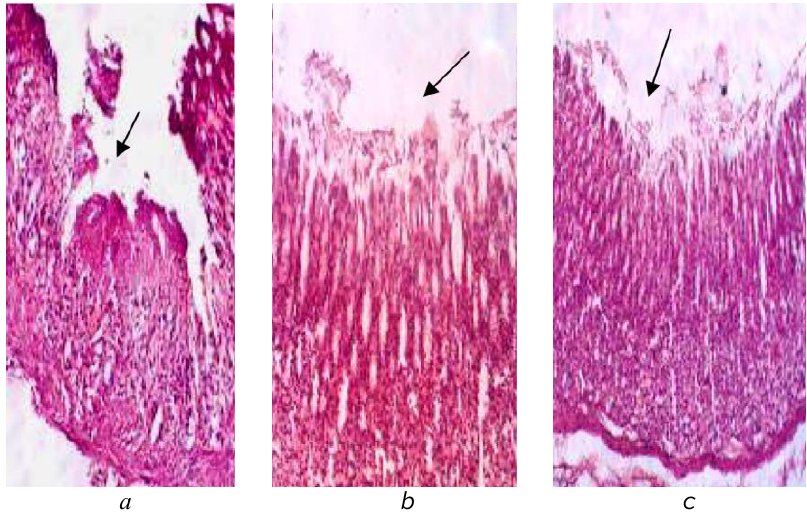
Fig. 13. The stomach of rats with administered Altan at a dose of 1 mg/kg on the background of an alcohol- prednisolone mixture: a – acute ulcer in the prepyloric section; extensive surface erosion in various parts of the mucous membrane ( b – prepyloric, c – pyloric). Haematoxylin-eosin.